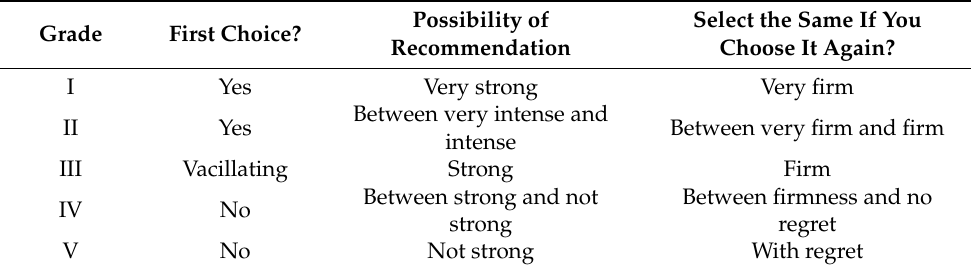
Table 2. Grading of Chinese residents’ willingness to buy